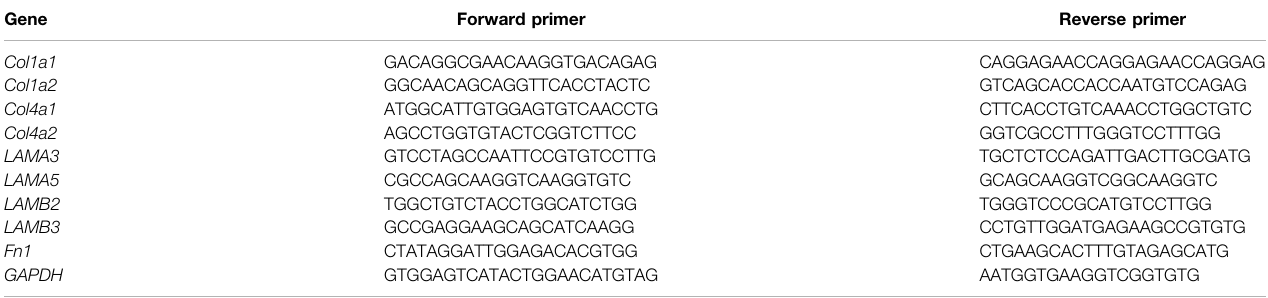
TABLE 3 | Primer sequences.